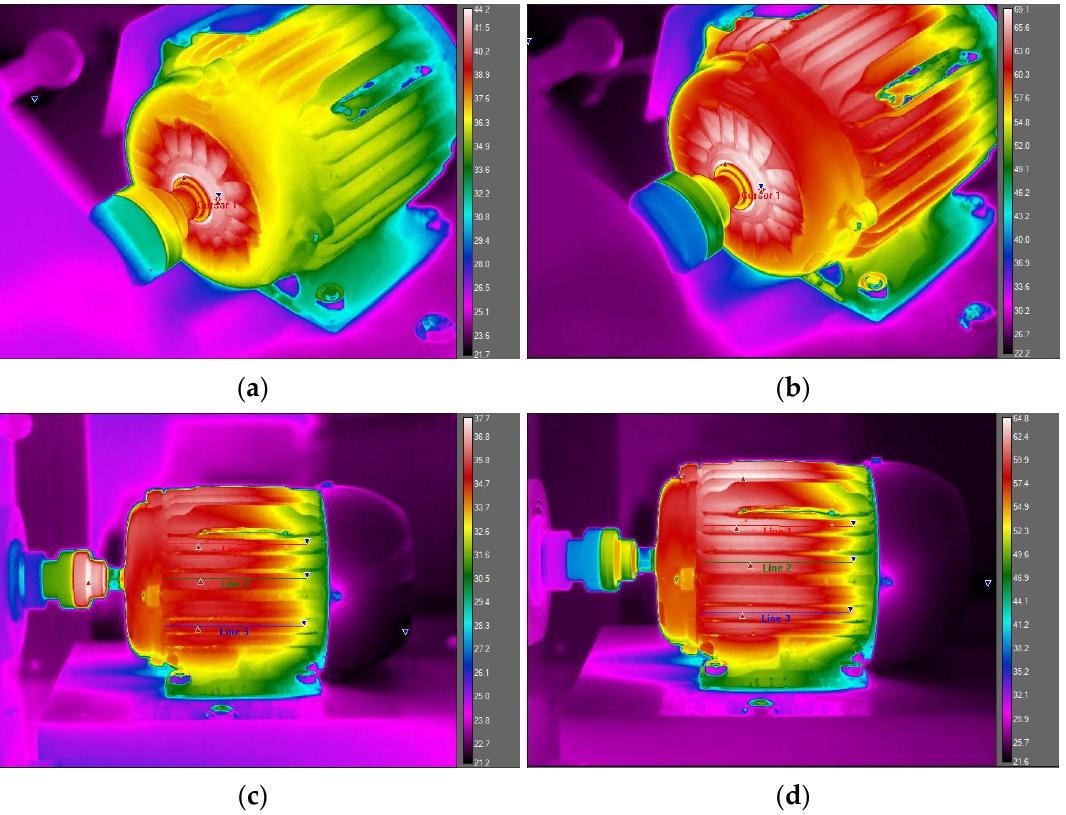
Figure 9. Thermographic images of the line-start permanent magnet motor in presence of 2nd-order voltage harmonics in frontal and lateral view: ( a ) thermal equilibrium frontal view; ( b ) 25% of 2nd- order voltage harmonic in frontal view; ( c ) thermal equilibrium lateral view; ( d ) 25% of 2nd-order voltage harmonic in lateral view.